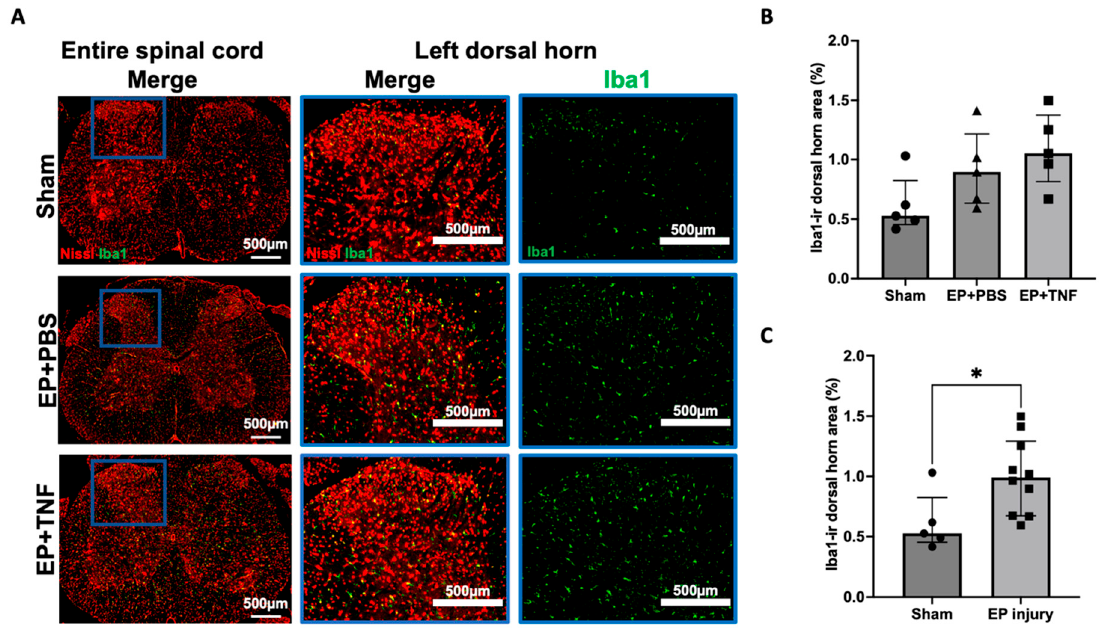
Figure 4. EP injury increased SubP in spinal dorsal horn with no effect of injectate. ( A ) Representa- tive images of SubP immunohistochemical staining with Nissl stain in the entire spinal cord and left dorsal horn. ( B ) EP injury with PBS and TNF α injections increased SubP-ir in the spinal cord dorsal horn. ( C ) Combined EP injury increased SubP-ir in the spinal cord dorsal horn. * p < 0.05. ** p < 0.01.